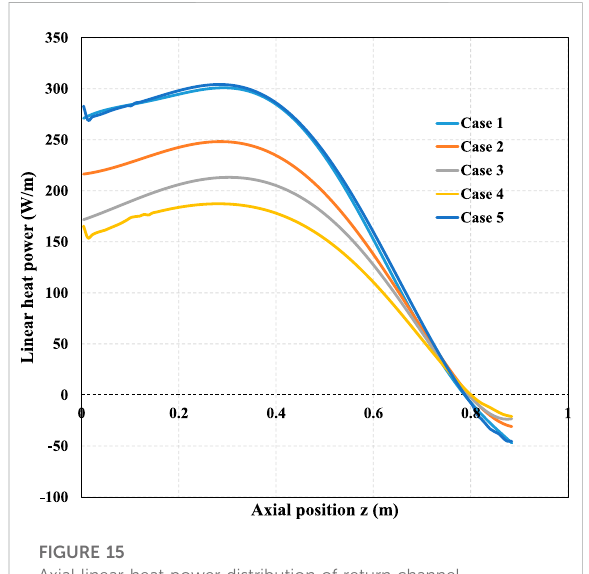
FIGURE 16 Nu calculation of the fuel channel in case 2.